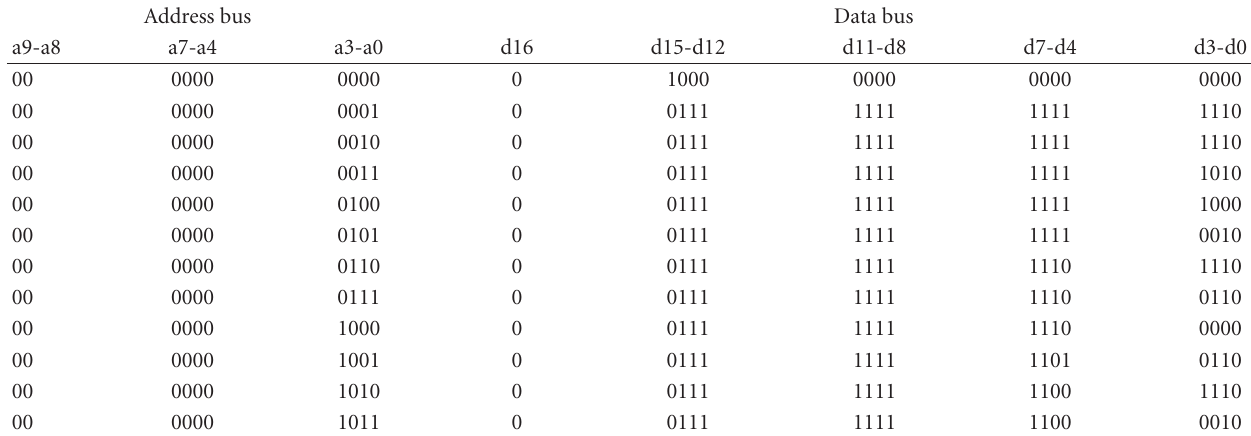
Table 1: Selection of preestablished data for a cosine